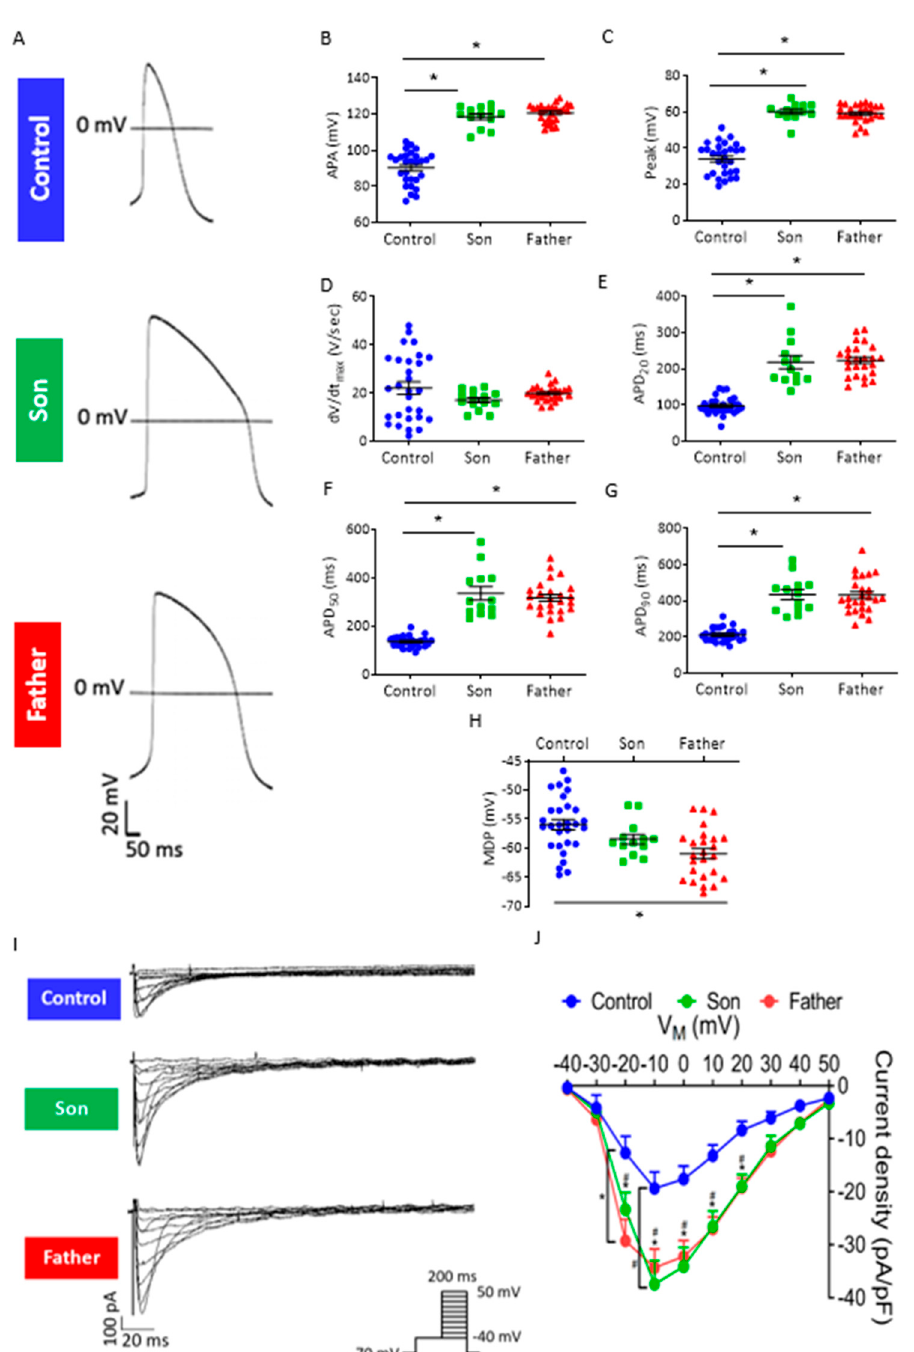
Figure 4. Action potential characteristics and I Ca,L in control, son and father iPSC-CMs. ( A ) Representative APs of